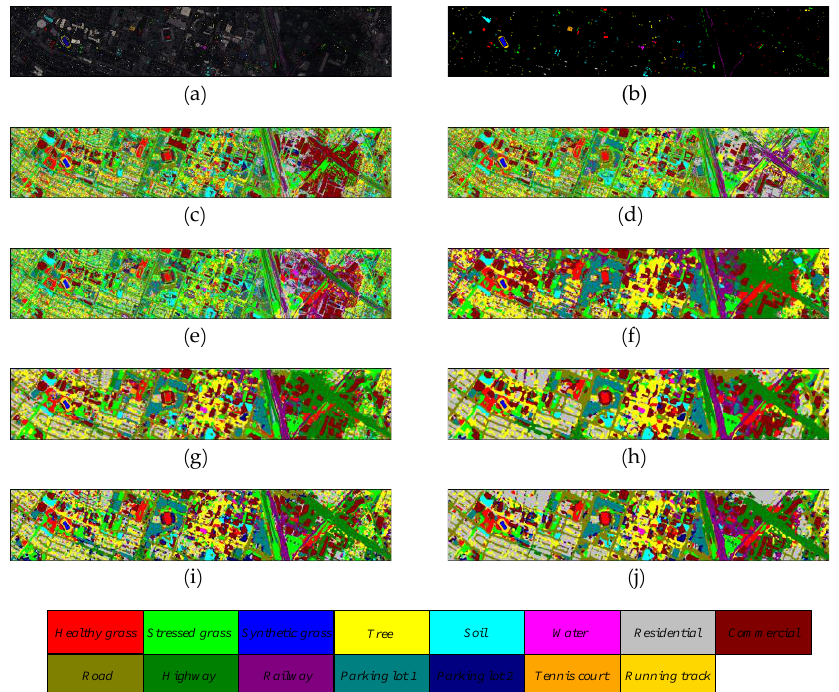
Figure 11. The classification maps of different methods on Grass_dfc_2013 dataset. ( a ) false color map with truth labels, ( b ) ground truth, ( c ) RBF-SVM, ( d ) MLR, ( e ) RF, ( f ) 2D-CNN, ( g ) PyResNet, ( h ) SSRN, ( i ) HybridSN, and ( j ) proposed.